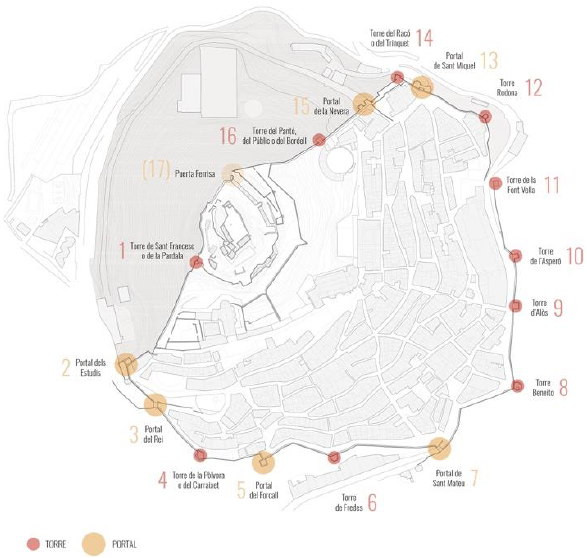
Figure 3. Distribution of the towers and gates of the walls of Morella (Source: Morella Town Council, modified by S. Portela,